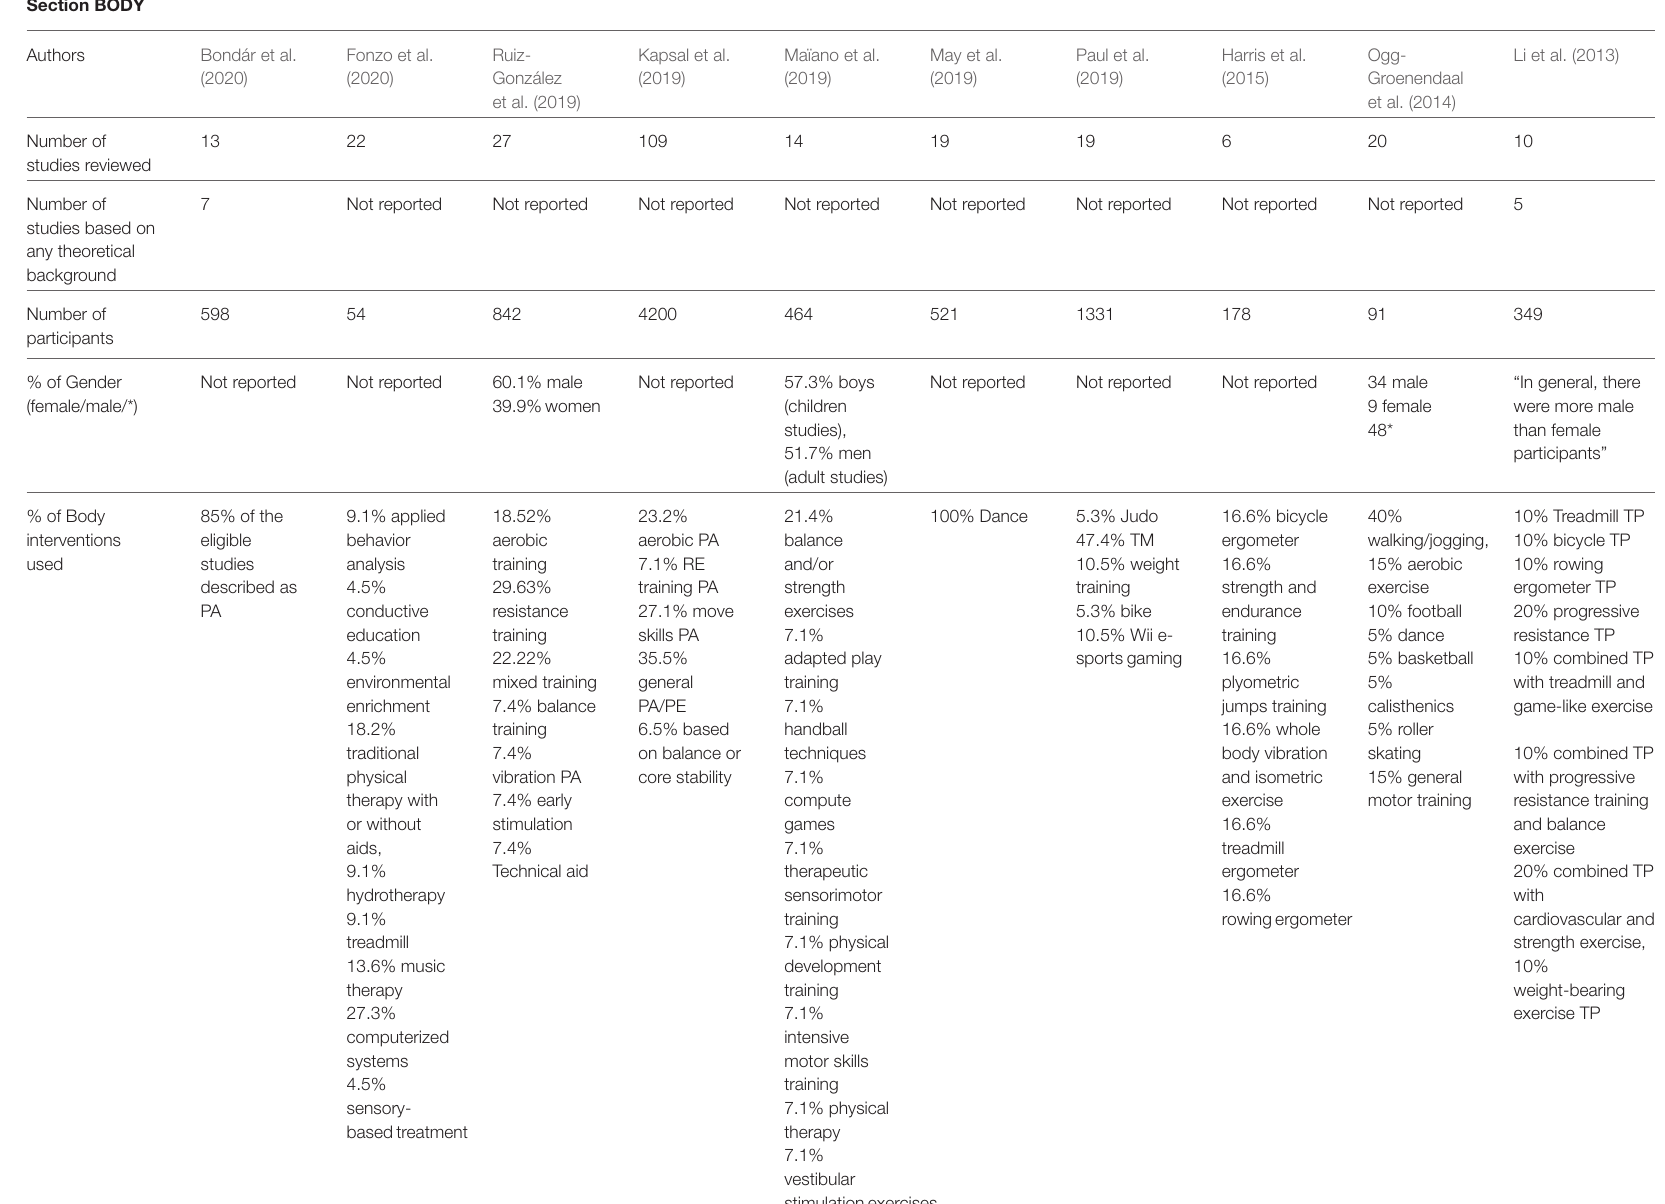
TABLE 1 | Overview of the 10 most cited reviews in regards to the topics body and mental interventions for intellectual disabled